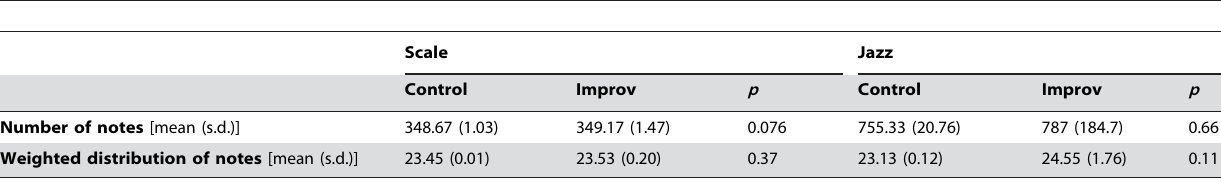
Table 1. MIDI piano data obtained during control and improvisation conditions for Scale and Jazz paradigms.